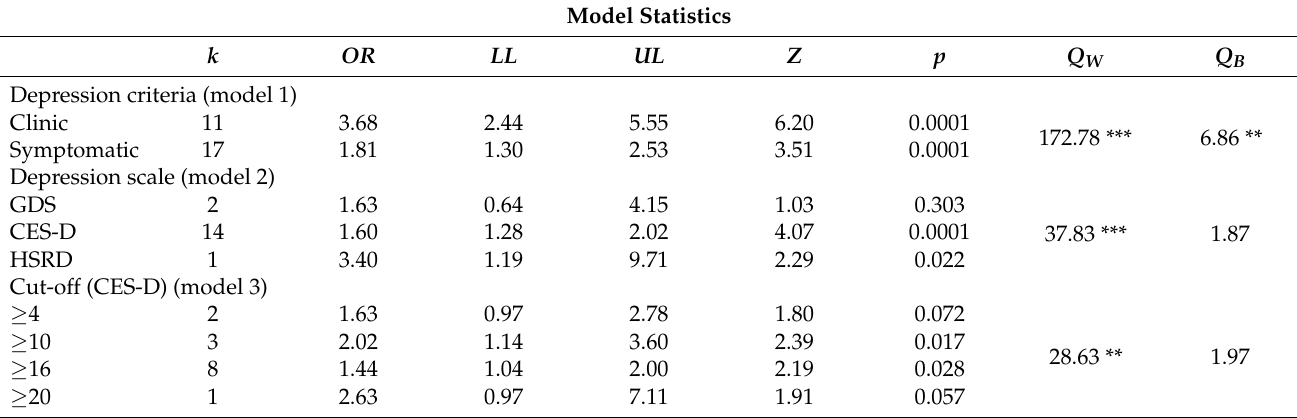
Table 3. Summary effect